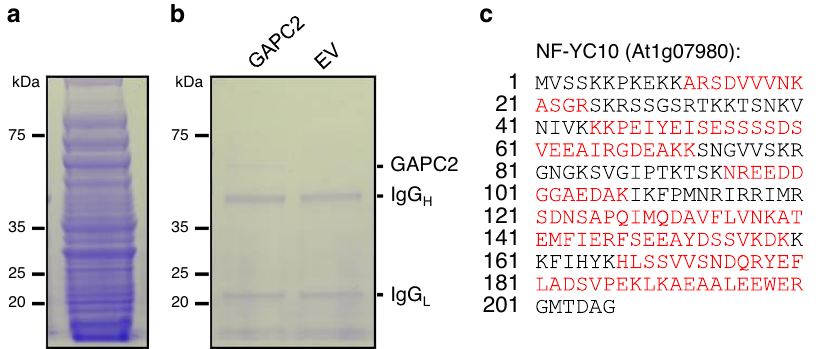
Fig. 1 Screening of Arabidopsis transcription factors to identify GAPC-binding proteins. a Mixture of the puri fi ed transcription factors. Proteins were puri fi ed by af fi nity chromatography and separated on a polyacrylamide gel. The gel was stained with Coomassie Brilliant Blue. Protein marker size is on the left. b Gel image of co-immunoprecipitation. Transcription factors co-immunoprecipitated with GAPC2-Flag or empty vector control (EV) were separated on a polyacrylamide gel and stained with Coomassie Brilliant Blue. Protein marker size is on the left. Positions of GAPC2, immunoglobulin G (IgG) heavy and light chains are on the right. c Mass spectrometry-based identi fi cation of NF-YC10. Trypsin-digested peptides from the immunoprecipitated samples were sequenced by LC-MS/MS. Shown here is NF-YC10 sequence with the unique peptides in red that were identi fi ed with probability